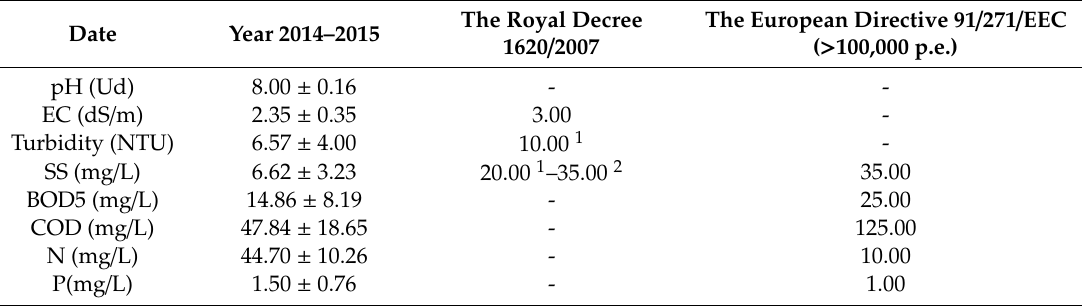
Table 2. Water quality data (average and standard deviation) provided by WWTP of Pobla de Farnals taken at the outlet compared to the National and European directives.